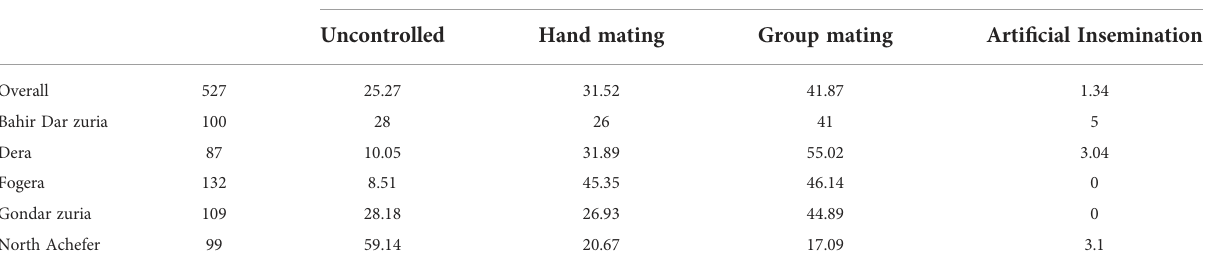
TABLE 9 Types of mating practiced in the study districts.